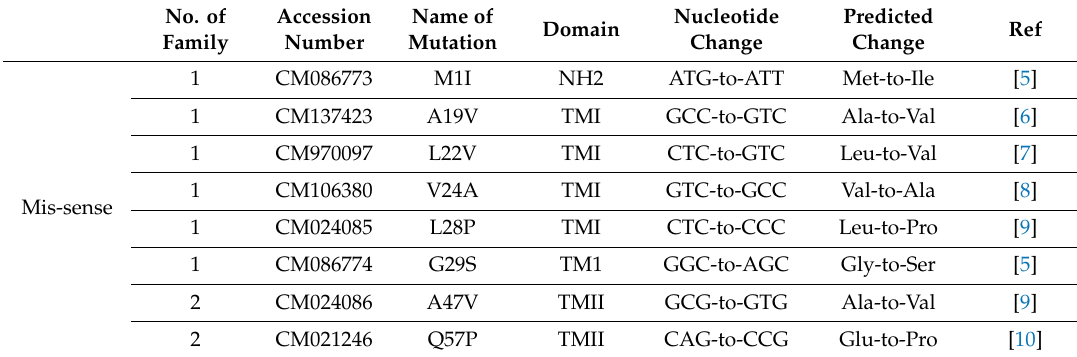
Figure 1. Diagram of the AQP2 protein and the locations of the affected residues by the putative disease-causing AQP2 mutations. AQP2 is depicted with six transmembrane domains. The extracellular, transmembrane and cytoplasmic domains are represented as reported [4]. Solid symbols indicate the affected residues because of the mutations (Table 1). Table 1. Potential disease-causing mutations in AQP2.